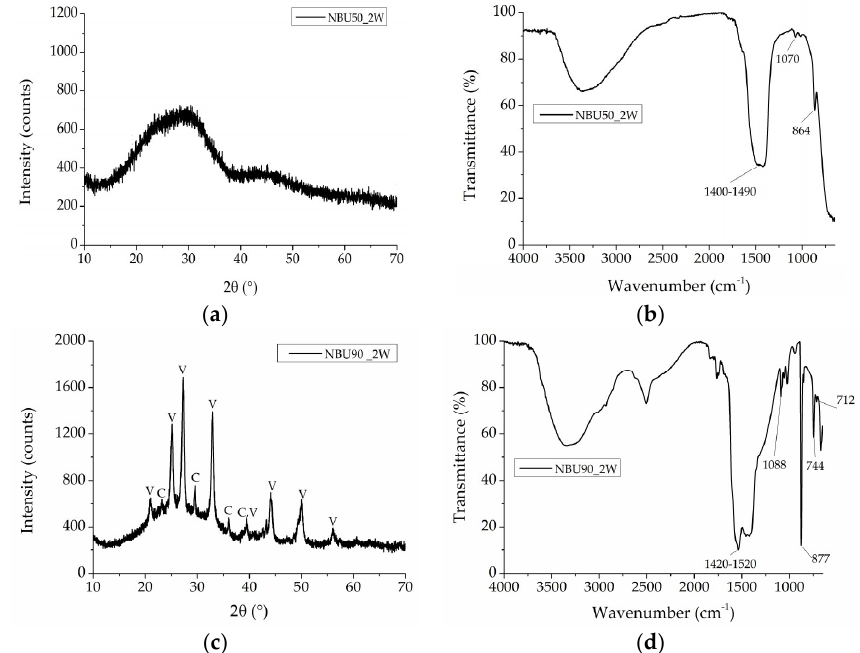
Figure 6. XRD and µ FT-IR analyses of NBU after two weeks: ( a ) XRD pattern at 50% RH (NBU50_2W), ( b ) µ FT-IR spectrum 50% RH (NBU50_2W), ( c ) XRD pattern at 90% RH (NBU90_2W) and ( d ) µ FT-IR spectrum at 90% RH (NBU90_2W). XRD peak assignments: C, calcite; V,